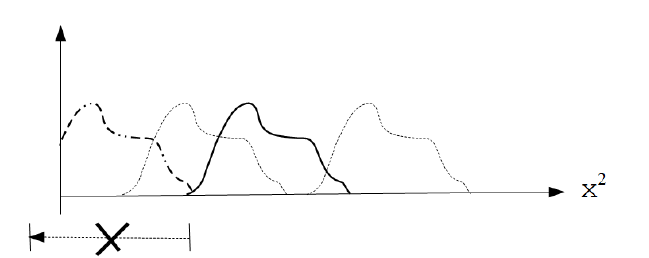
Figure 3. All translations to the right and some translations to the left are unitary, as opposed to those translations to the left that decrease the area under the curve. The disallowed translations cannot bring us to the negative axis of R , yet they influence the norm of the state vector. Any shift to the right is unitary and reversible (local reversibility). In this sense, the global arrow of time coexists with local reversibility of time evolution. Note that the shifted variable is not x but x 2 (for n = 1 + 1), and x n for arbitrary n . The shift in x n shrinks the time-like width of the membrane when plotted in plain x